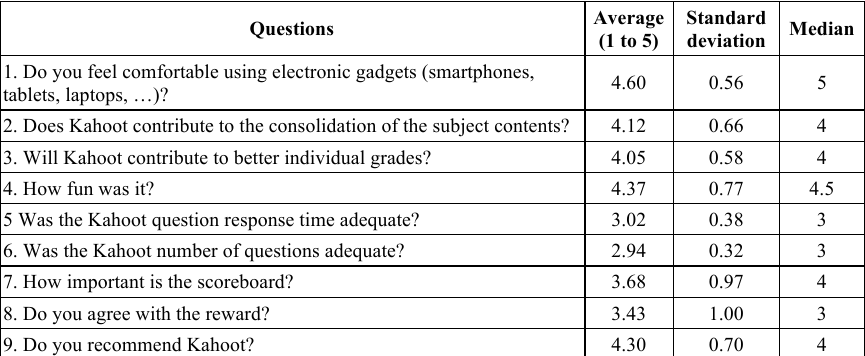
Table 3. Results of individual